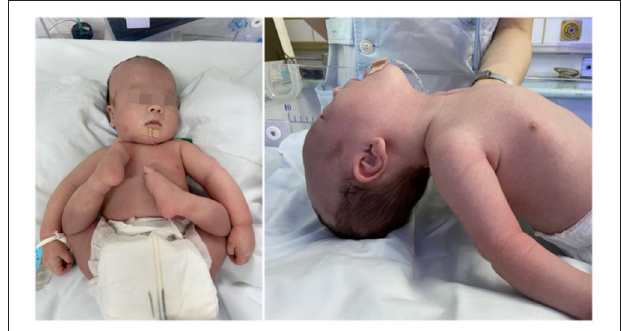
FIGURE 1 | The patient with severe hypotonia and facial